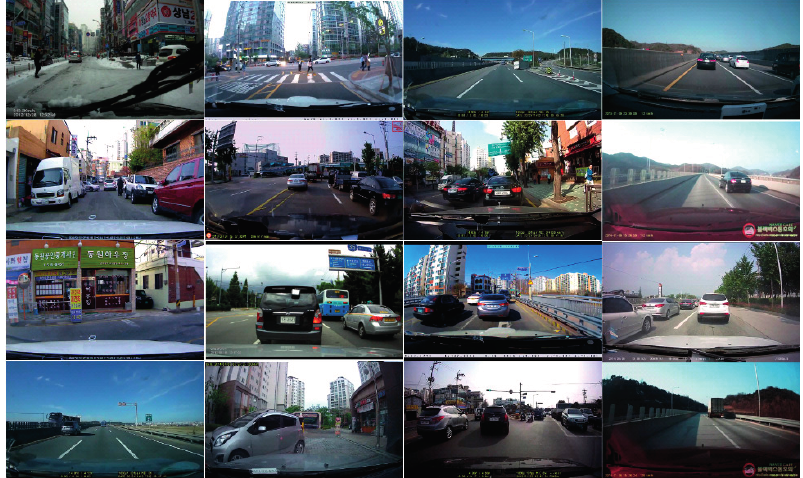
Figure 6. Twelve sample images recorded by a conventional vehicular camera and used for the performance evaluation (24 fps, MPEG-4, WVGA, and 10 s).